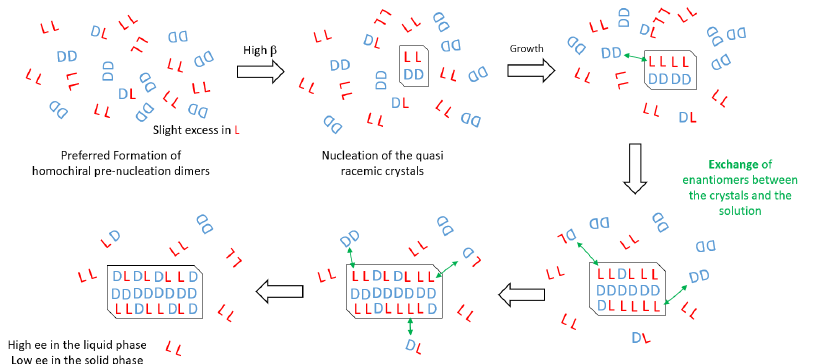
Figure 7. Schematic representation of the PE mechanism occurring during the crystallization of ArgFum under high supersaturation conditions. The pre-nucleation clusters are represented as dimers by analogy with the crystal structure of DL-ArgFum.